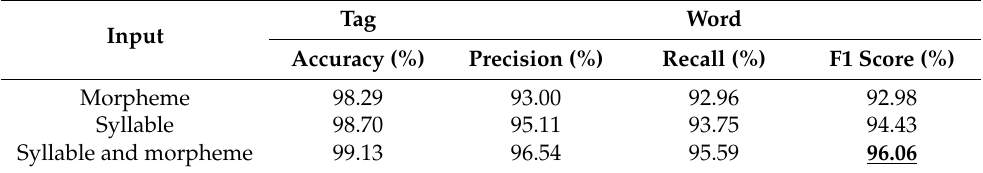
Table 5. Performance result of spacing correction. Marked in bold and underline is the best performance. Input